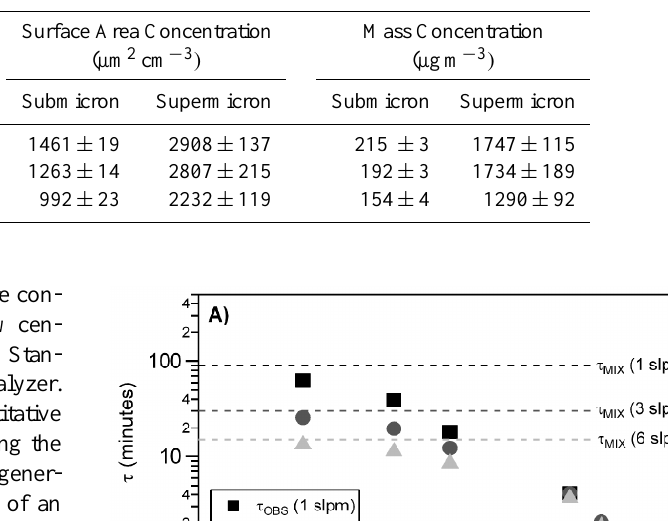
Table 1. Steady-state number, surface area, and mass concentrations measured as a function of the supplied synthetic air to the portable tank. The reported value represents the mean and standard deviation (1 σ) . The mass concentration assumes a particle density of 1.8 gcm − 3 .